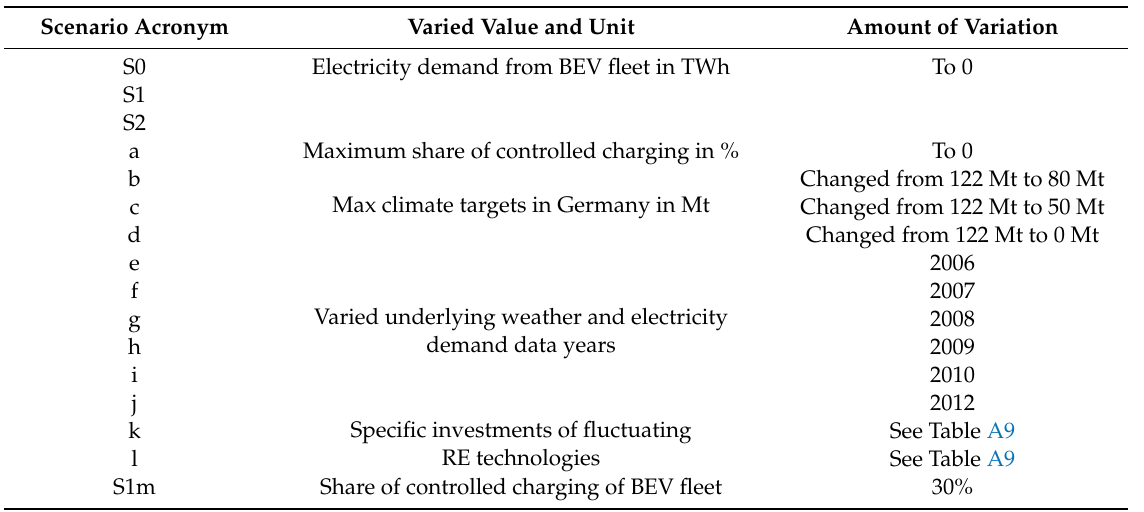
Overview Table of All Model Runs Carried out in the Scenario Study Table A6. Overview on model runs and respective scenario acronyms